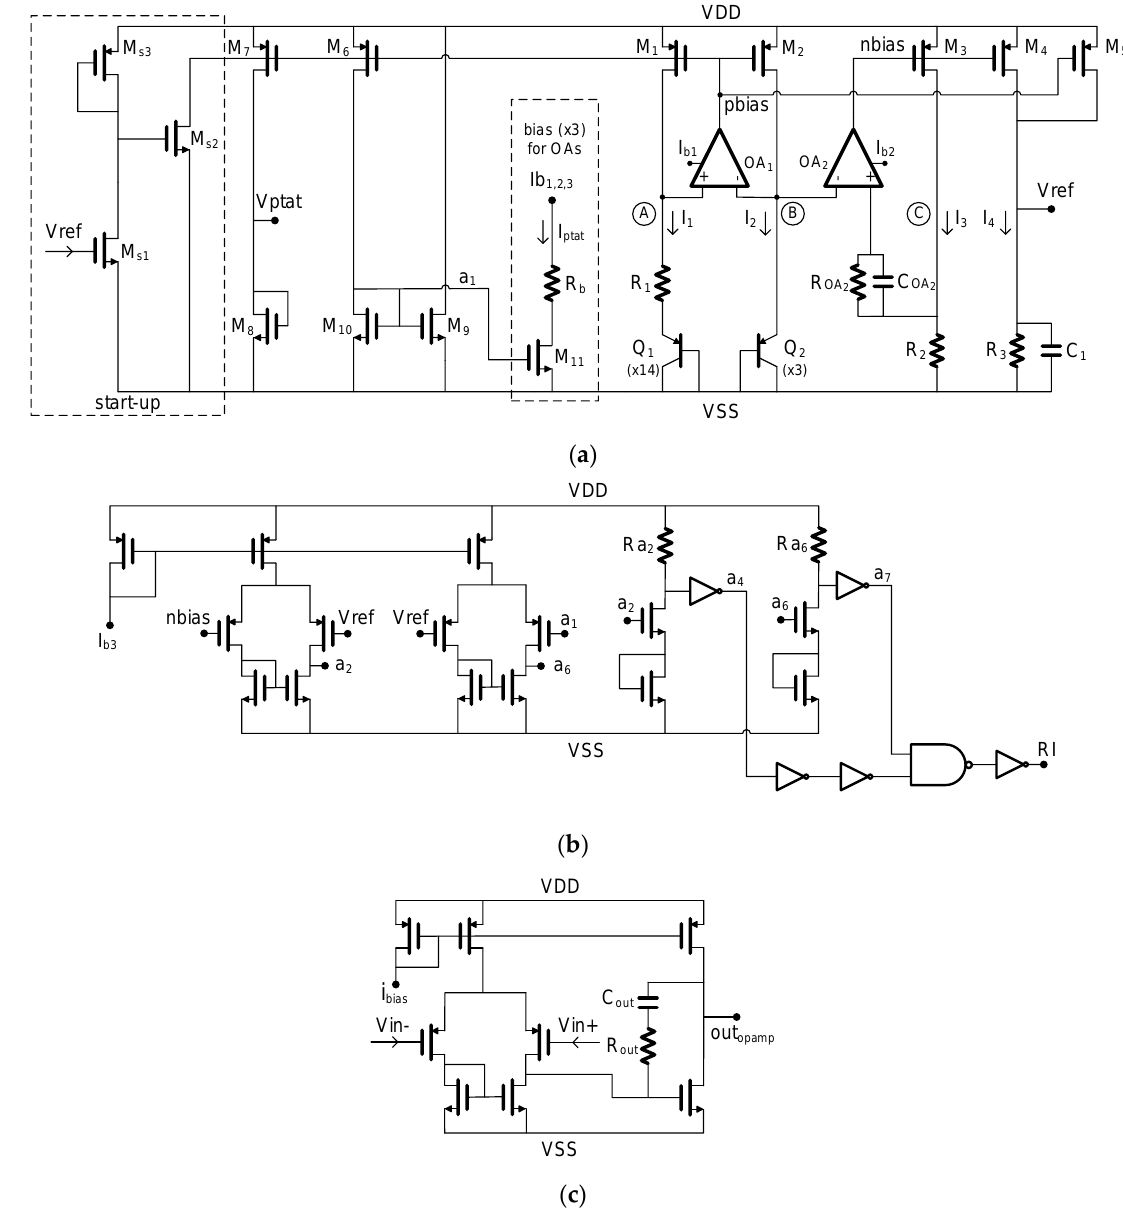
Figure 9. BGR#2 in CMOS 65 nm technology, 1 V supply voltage ( a ) core circuit ( b ) RI circuit and ( c ) the operational amplifier circuit.